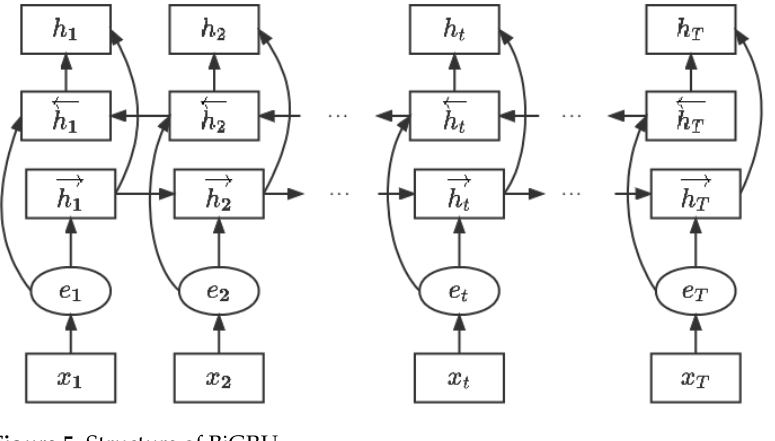
Figure 5. Structure of